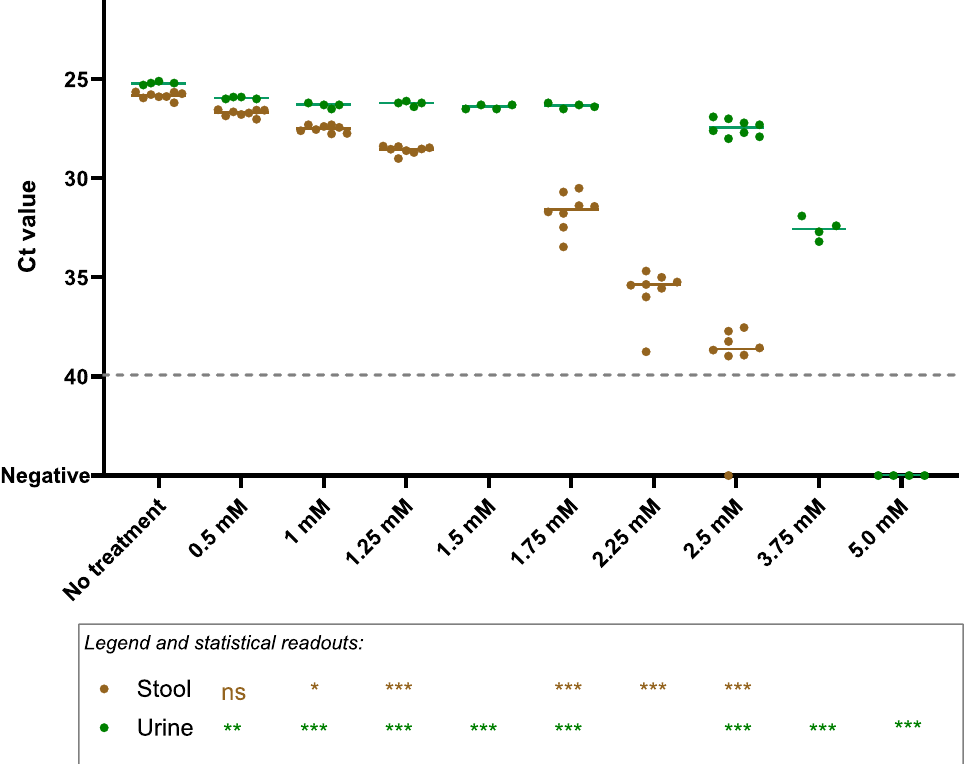
Figure 3. Platinum chloride (PtCl 4 ) viability RT-qPCR on ten-fold diluted faecal suspensions (1% w/v final dilution) (brown dots) and urine specimens (10% v/v final dilution) (green dots) spiked with approximately 10 5 gc/mL gamma-inactivated SARS-CoV-2. Dashed grey line represents RT-qPCR theoretical limit of detection. Asterisks indicate significant difference from untreated control: * p < 0.01; ** p < 0.001; *** p < 0.0001; ns, not